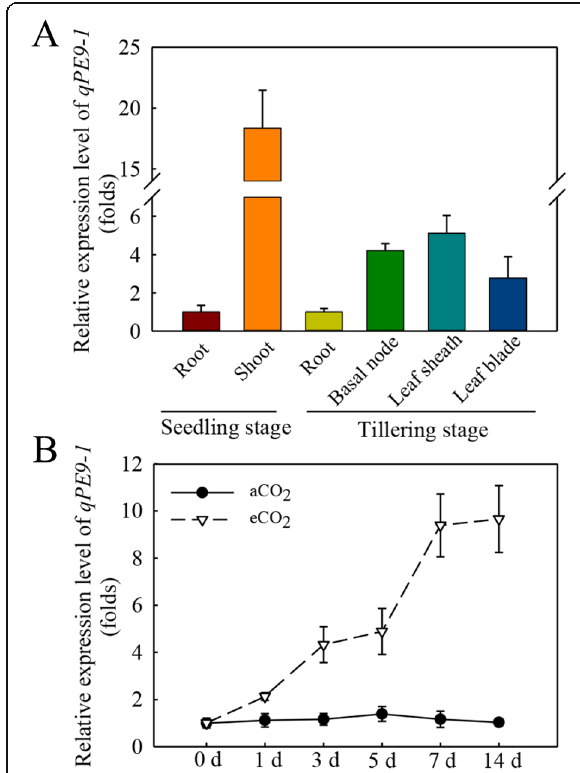
Fig. 1 Analysis of qPE9-1 expression pattern under aCO 2 or eCO 2 using RT-qPCR in the rice plants. ( A ) Expression levels of qPE9-1 in the indicated tissues of WT at seedling and tillering growth stages under aCO 2 . The shoots included leaf blade and leaf sheath at seedling stage. The leaf sheath and leaf blade of newly expanded leaf were taken for the measurement at tillering stage. ( B ) Time course of qPE9-1 expression at seedling stage after exposed to eCO 2 . WT seedlings were transferred to aCO 2 and eCO 2 conditions and then the leaves samples were harvested at the indicated time points for RNA extraction. The value before treatment (0 d) set as 1, and then gene expression is relative to it. OsActin was as an internal reference. Values are means± SD; different letters indicate significant differences ( P <